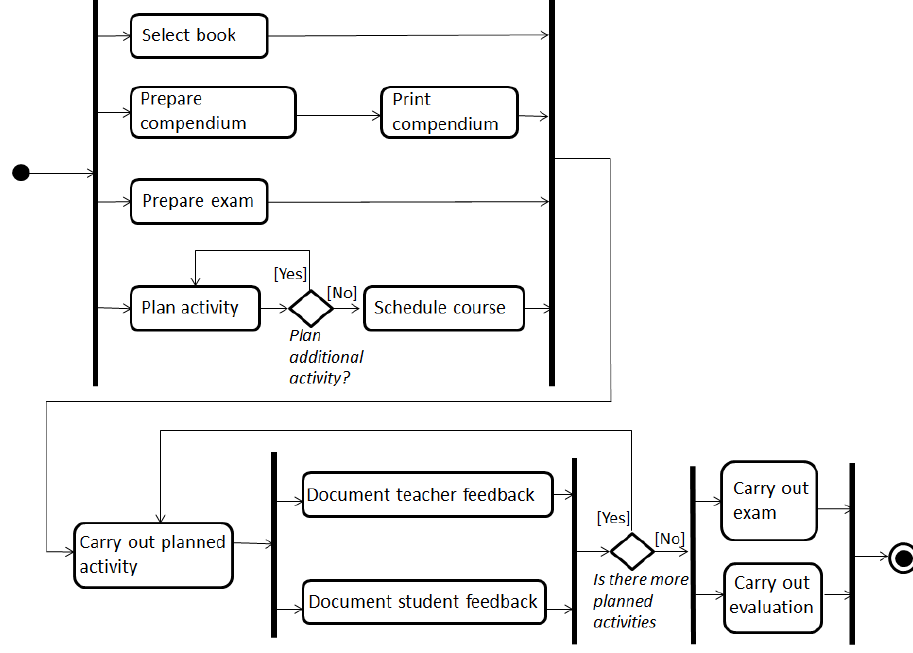
Figure A1. A possible workflow model for the course